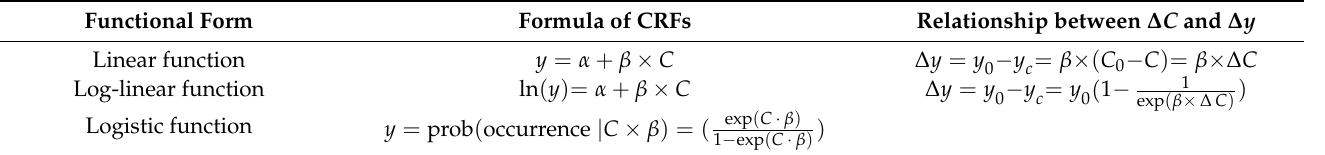
Table 4. CFRs in health impact risk